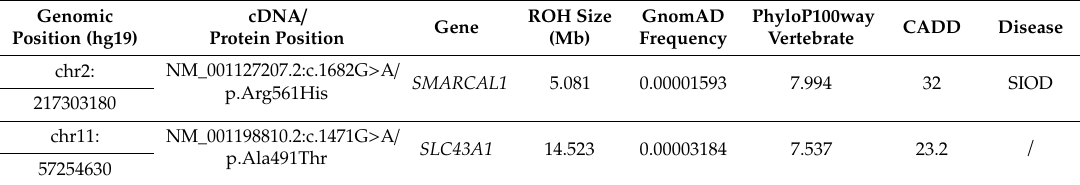
Table 2. Analysis of WES: potentially interesting variants associated with clinical phenotype. Genomic Position